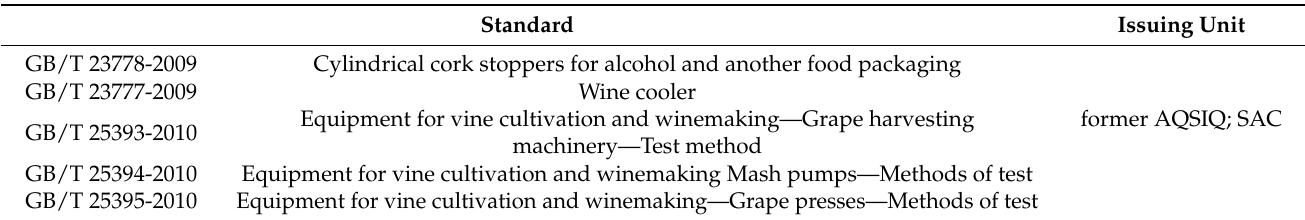
Table 7. National standards of wine-related products and